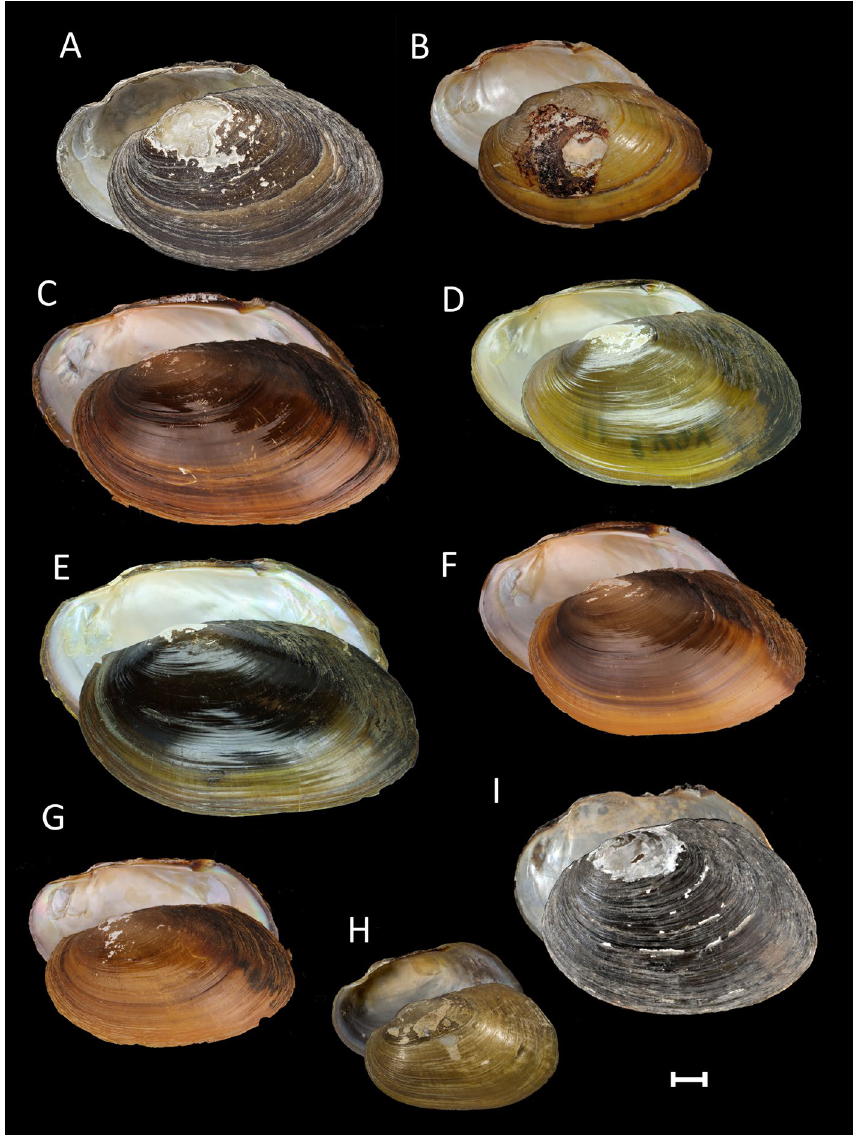
Figure 3. Shells of Thaiconcha species from the Mekong basin and questionable taxa. ( A ) T. callifera (Martens, 1860) [syntype NHMUK 1859-8-1-20]; ( B ) Pseudodon ellipticum Conrad, 1865 [syntype ANSP 41763] (=